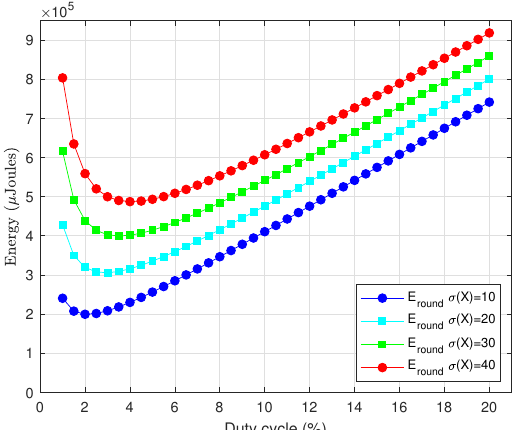
Figure 17. Energy consumption per round in terms of the duty cycle.